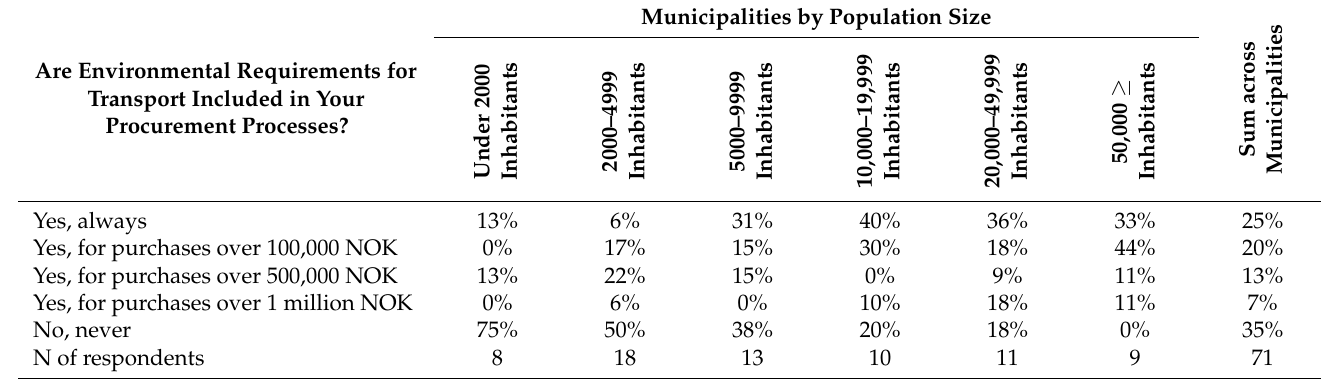
Table 5. Municipalities practice in terms of threshold values for applying of requirements.